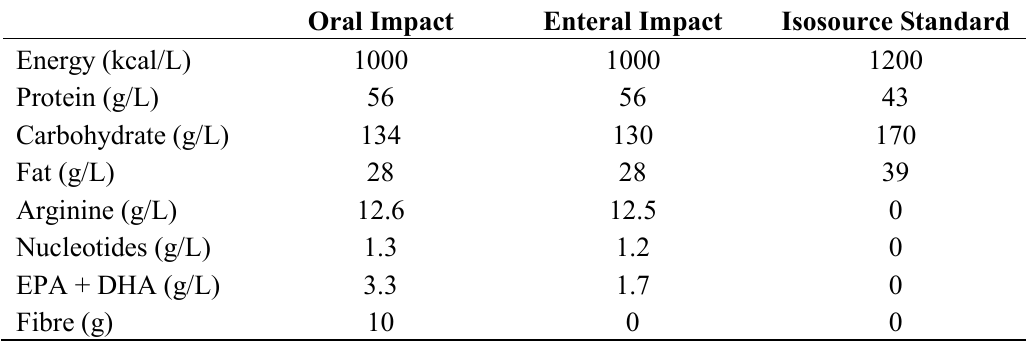
Table 1. Composition of oral and enteral